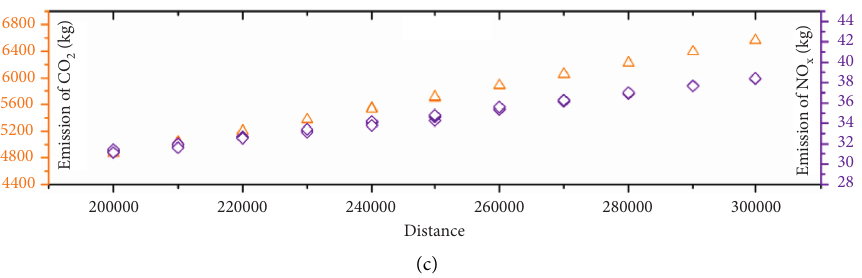
Figure 11: Influence of flight distance on optimization results.